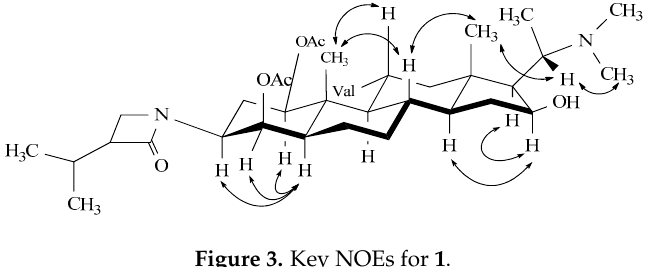
Figure 3. Key NOEs for 1 .